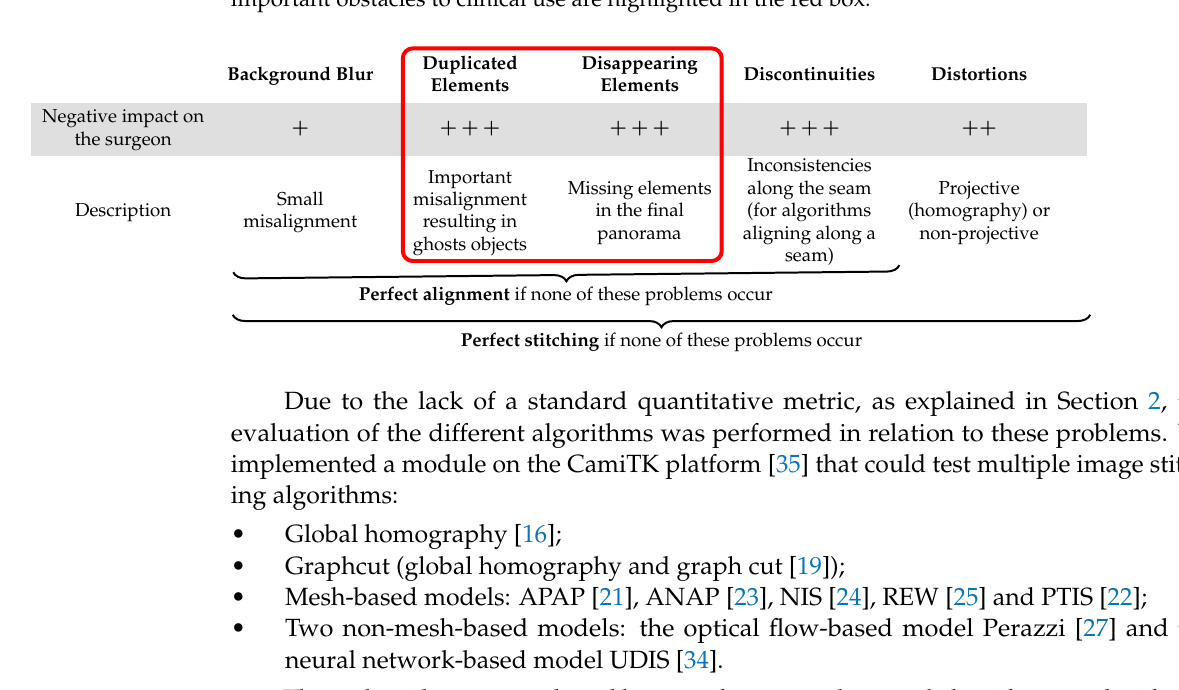
Table 2. The main problems of image stitching and their potential impacts on surgeons. The most important obstacles to clinical use are highlighted in the red